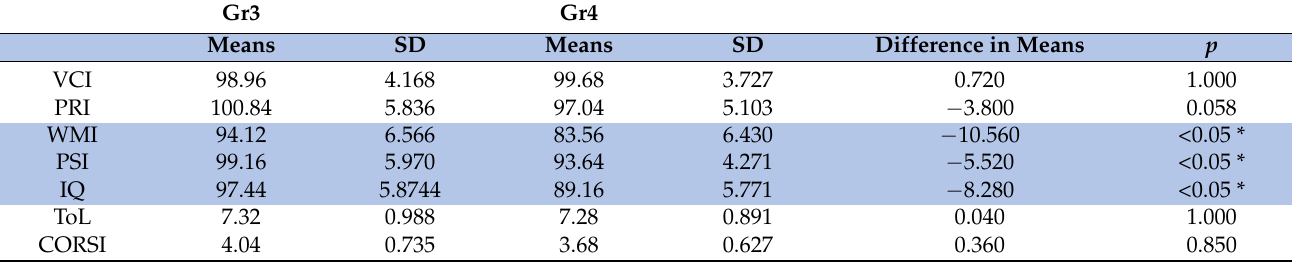
Table 6. Post hoc between Gr3 and